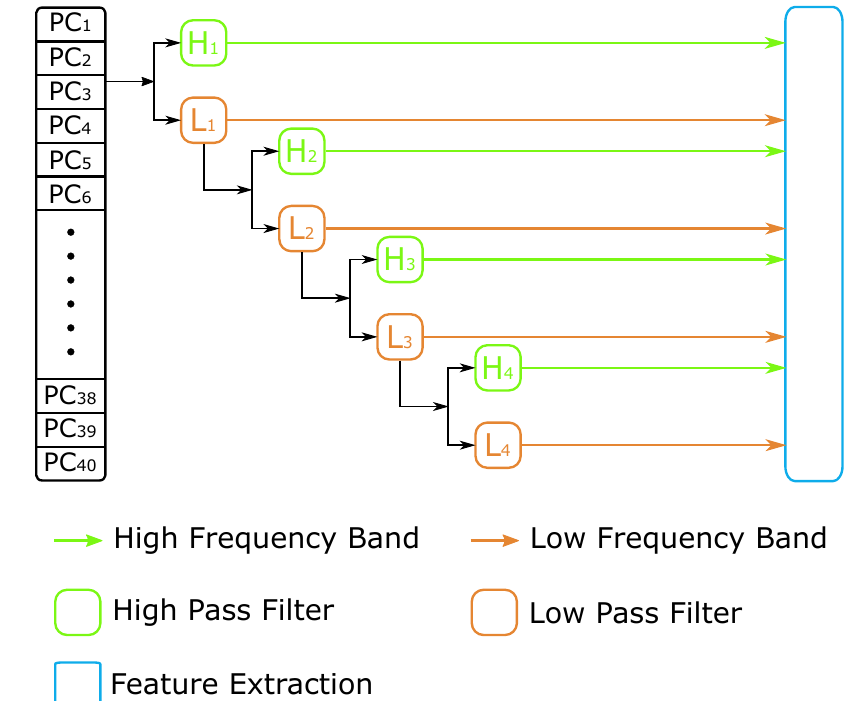
Figure 2. The discrete wavelet transform